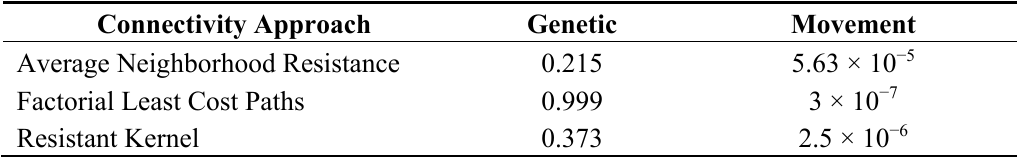
Table 1. Proportion of instances, of 1 × 10 − 7 random samples, where a random draw of 56 locations along U.S. Highway 95 in the study area produced a median connectivity value higher than the median connectivity value of the 56 actual black bear crossing locations for the two resistance maps across the three connectivity modeling approaches. The connectivity maps are a combination of the type of resistance surface (genetic based or movement based) and the type of connectivity modeling approach (average neighborhood resistance, factorial least cost path and resistant